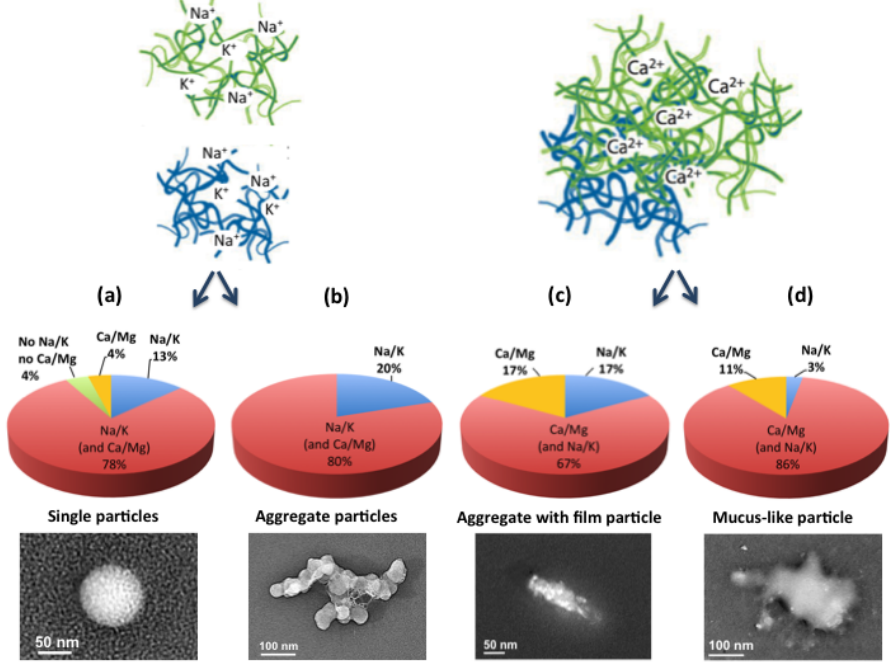
Figure 11. Fraction of particles containing the following ions: Na + /K + (blue), Ca 2 + /Mg 2 + (yellow), Na + /K + and minor contents of Ca 2 + /Mg 2 + (red), and neither Na + /K + nor Ca 2 + /Mg 2 + (green). (a) Single particles comprised of gel matter; (b) “mucus-like” particles; (c) “aggregate” particles; (d) “aggregate with film” particles.